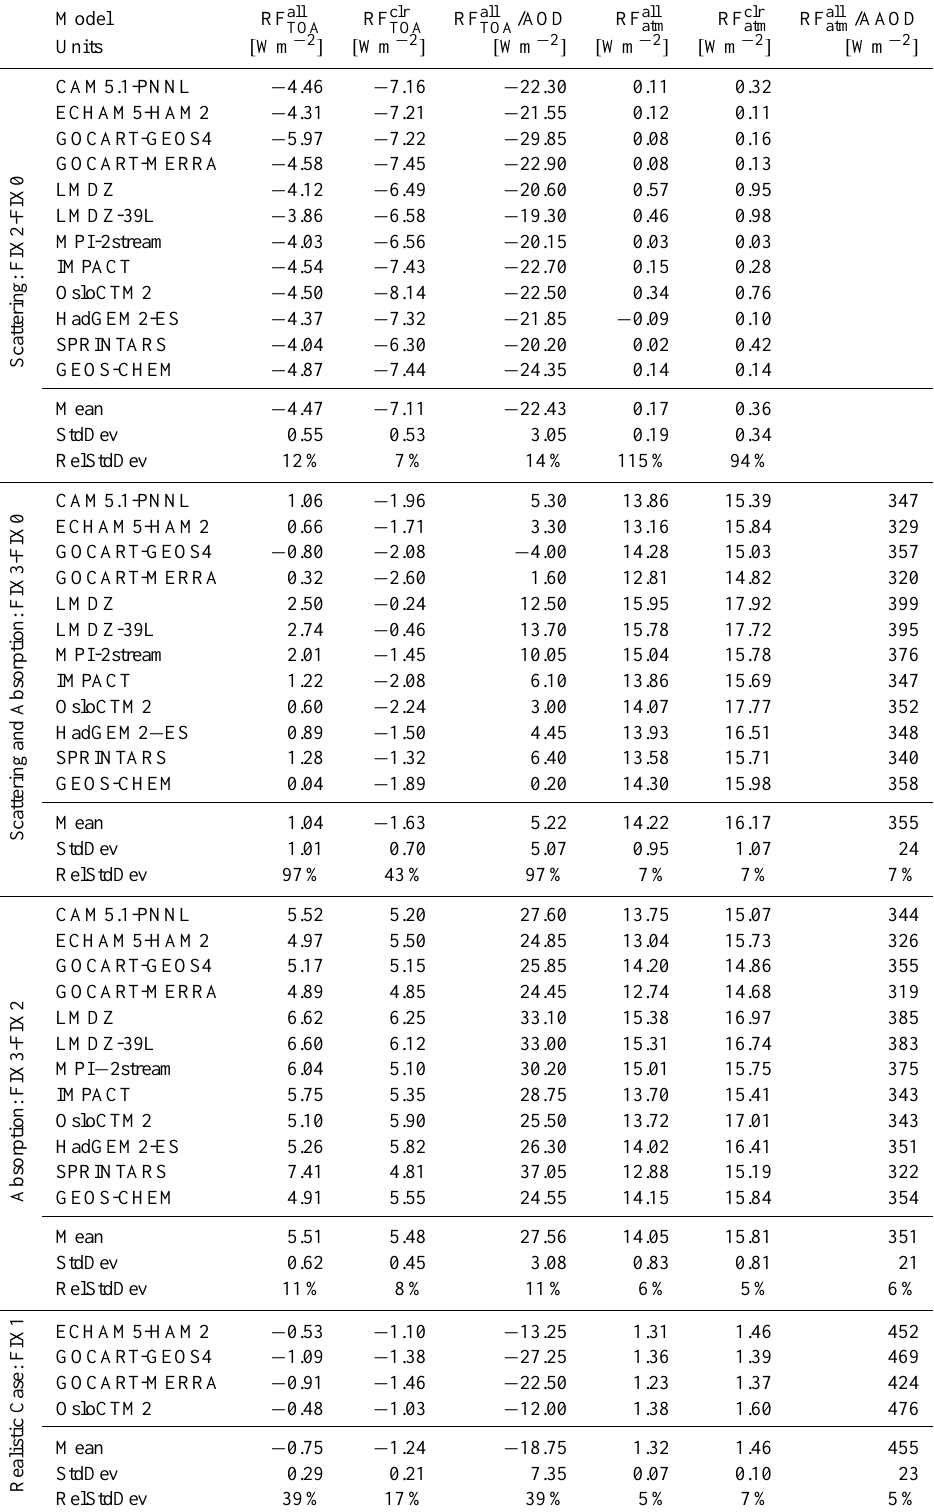
Table 3. Summary of annual-global mean radiative forcings for the FIX0,FIX2,FIX3 and the FIX1 intercomparison